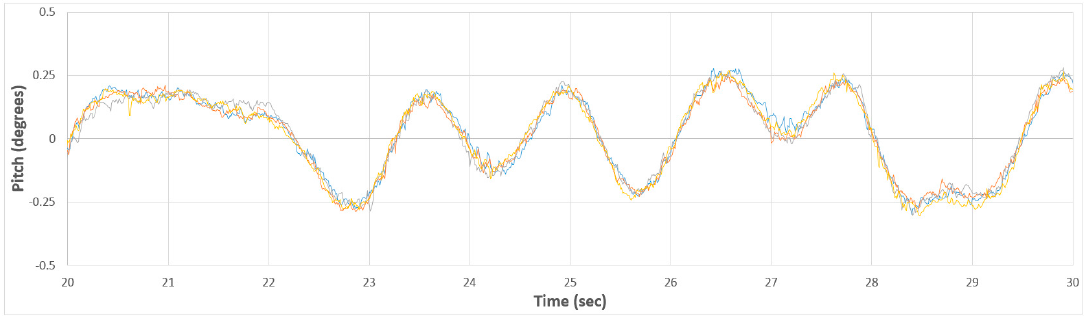
Figure 8. Sample time series Group A pitch.